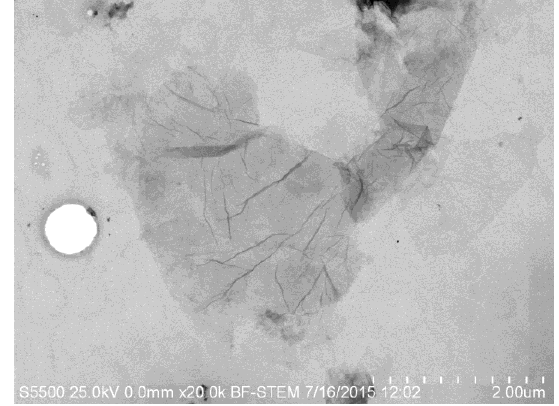
Figure 2. FESEM Image of GO in Transmission mode.